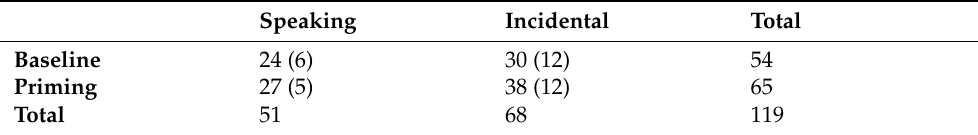
Table 4. Distribution of participants across conditions (number of men shown in